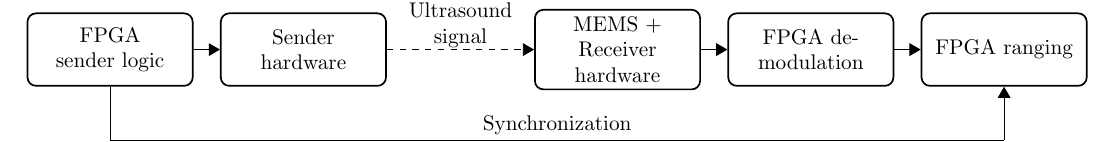
Figure 1. Setup of our experiments. For simplicity, only one transmitter and one receiver are represented in the Figure